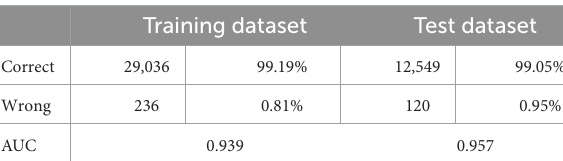
TABLE 4 The validation of TAN Bayesian